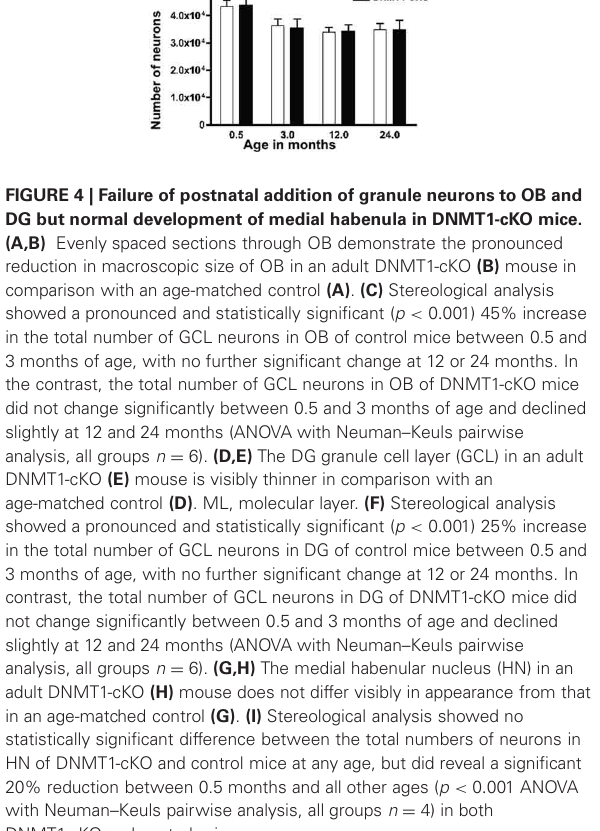
but significant decline in neuronal number of 16.5% between 2 FIGURE 4 | Failure of postnatal addition of granule neurons to OB and